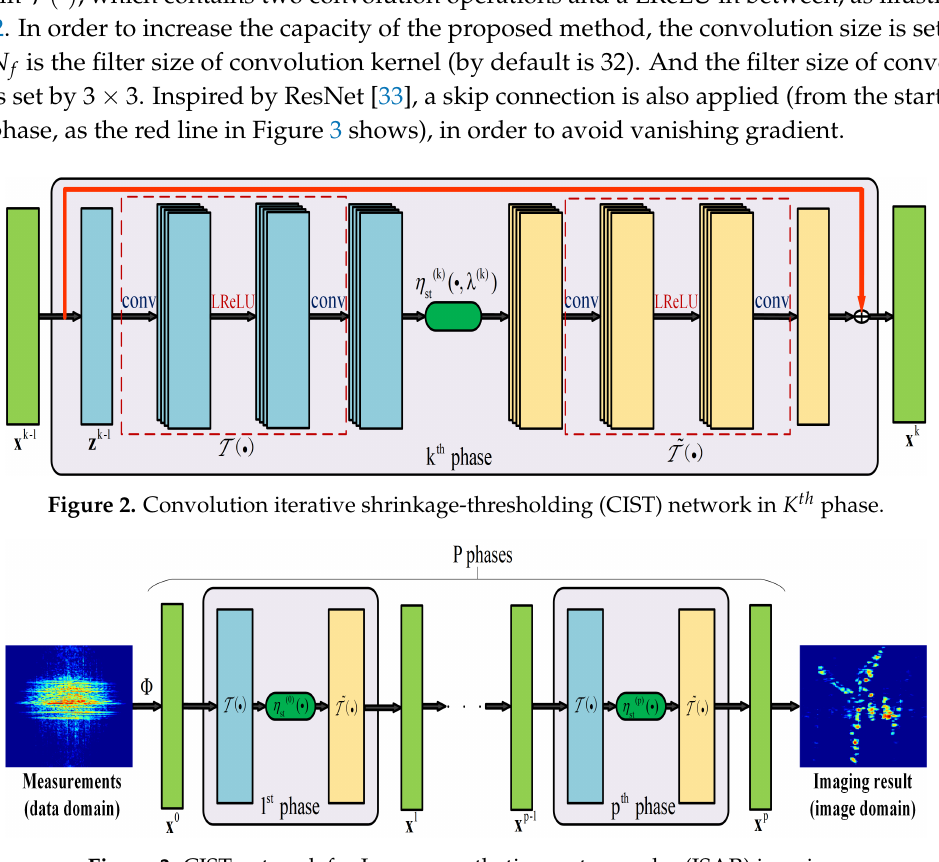
Figure 3. CIST network for Inverse synthetic aperture radar (ISAR)